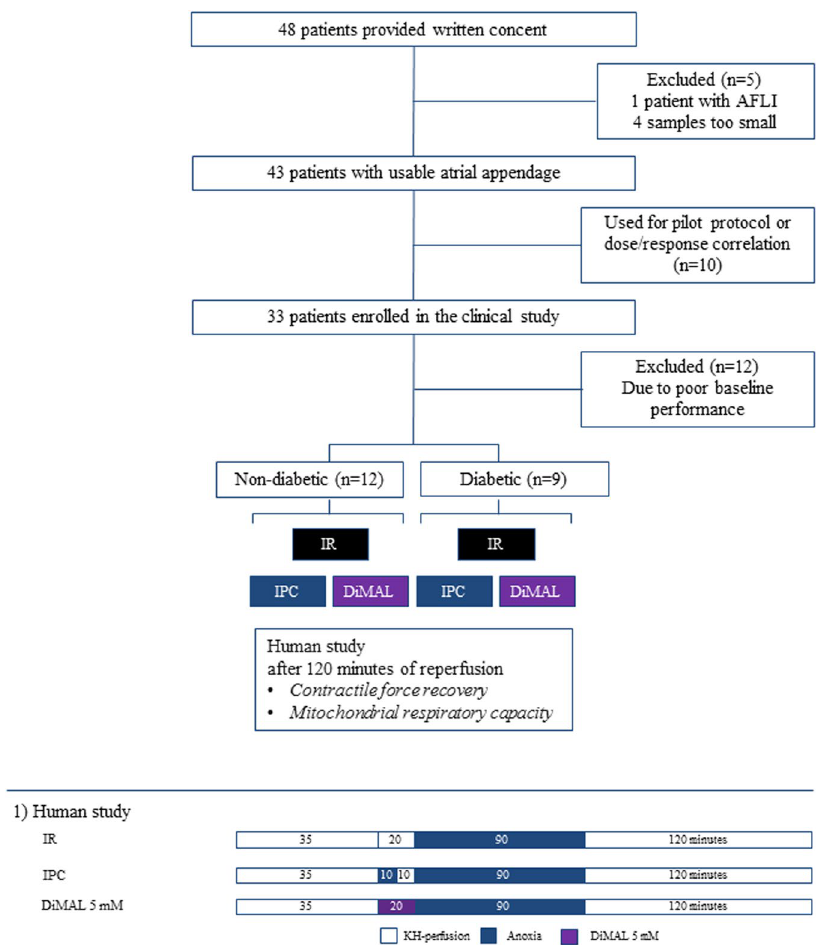
Figure 2. Study design of human study. An overview of the experimental series of the study including subgroups and perfusion protocols. IR: Ischemia reperfusion, IPC: Ischemic preconditioning, DiMAL: Dimethyl Malonate, AFLI: Atrial